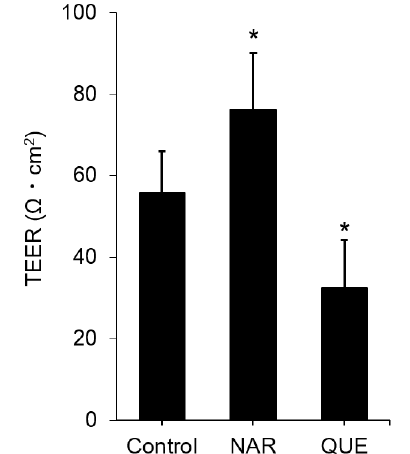
Figure 6. Effects of NAR and QUE on TEER in MDCK II cells. Cells were treated with the flavonoids (NAR or QUE) at a concentration of 100 μM for 48 h. Error bars indicate standard deviations. Statistical analyses were performed by Turkey–Kramer multiple comparison tests. Different from the value of the control cells, * p < 0.05. NAR: n = 5; QUE: n = 3. MDCK: Madin–Darby canine kidney, NAR: naringenin, QUE: quercetin, RUT: rutin, TEER: transepithelial electrical resistance.